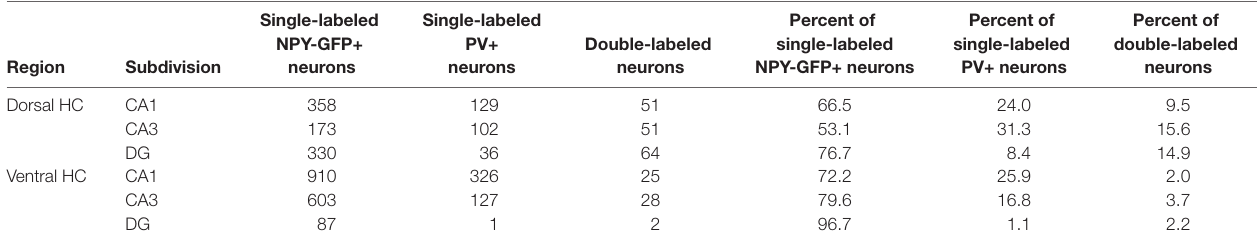
TABLE 4 | Co-localization of NPY-GFP and PV in the hippocampus. Single-labeled Single-labeled Percent of Percent of Percent of NPY-GFP+ PV+ Double-labeled single-labeled single-labeled double-labeled Region Subdivision neurons neurons neurons NPY-GFP+ neurons PV+ neurons neurons Dorsal HC CA1 358 129 51